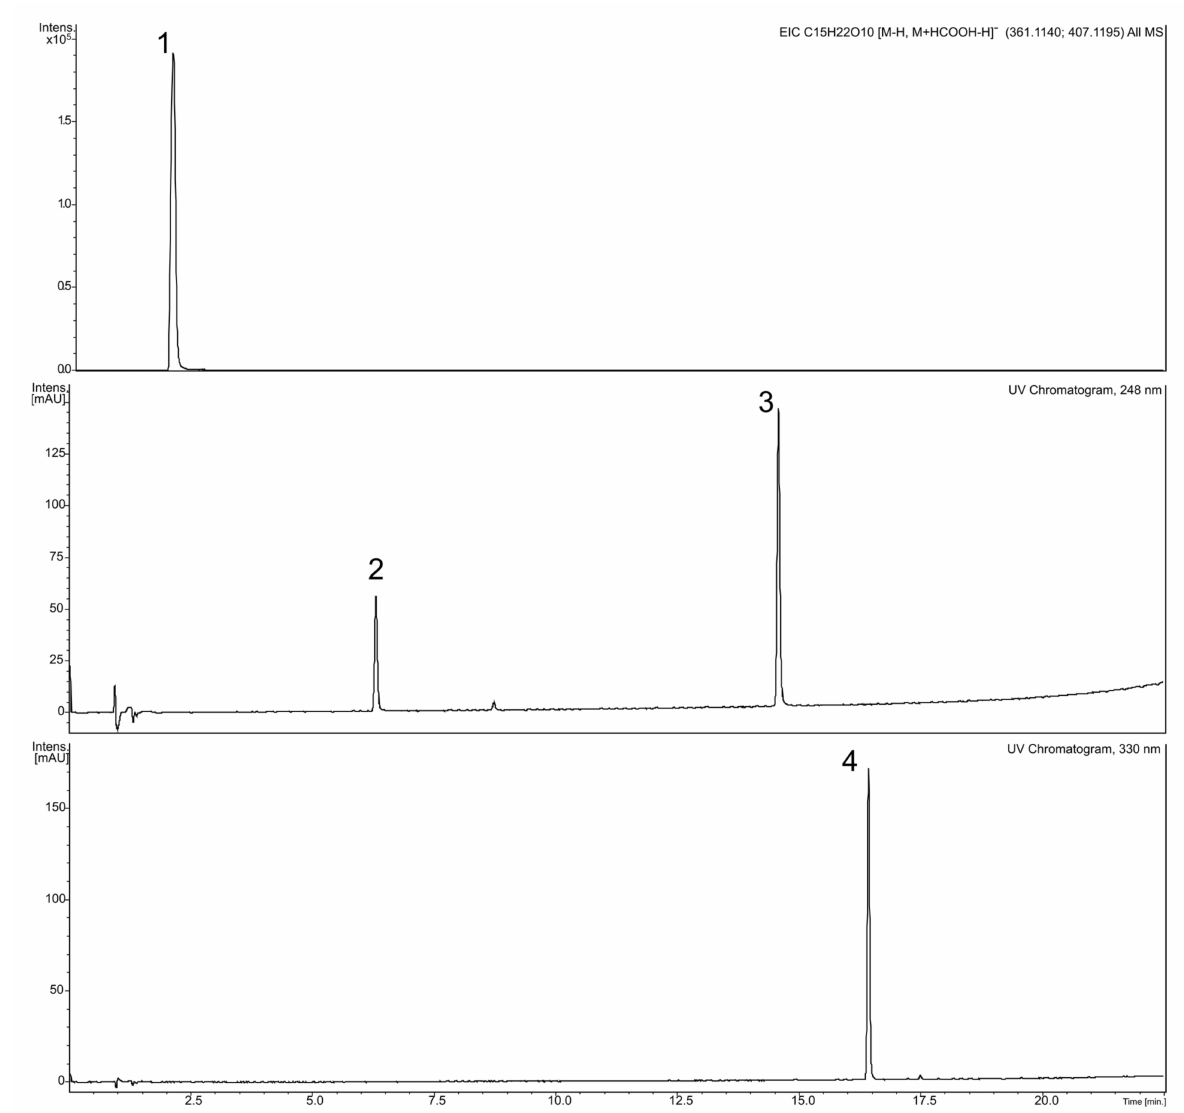
Figure 2. Chromatograms of isolated standards: 1—catalpol; 2—7-hydroxytomentoside; 3—apigenin- 7- O -glucuronopyranosyl-(1 → 2)-glucuronopyranoside);